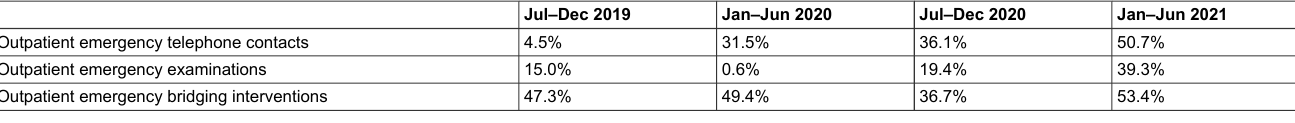
Table 3: Increase in % compared with previous period. % Change: difference from the period of the previous year divided by period of the previous